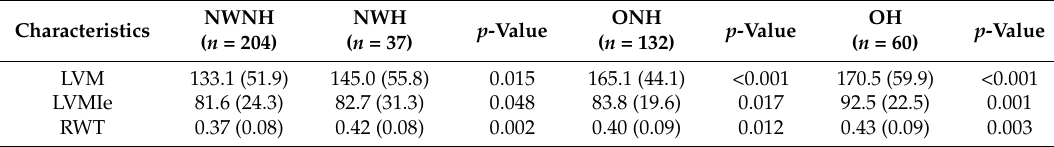
Table 3. Echocardiographic parameters of the study